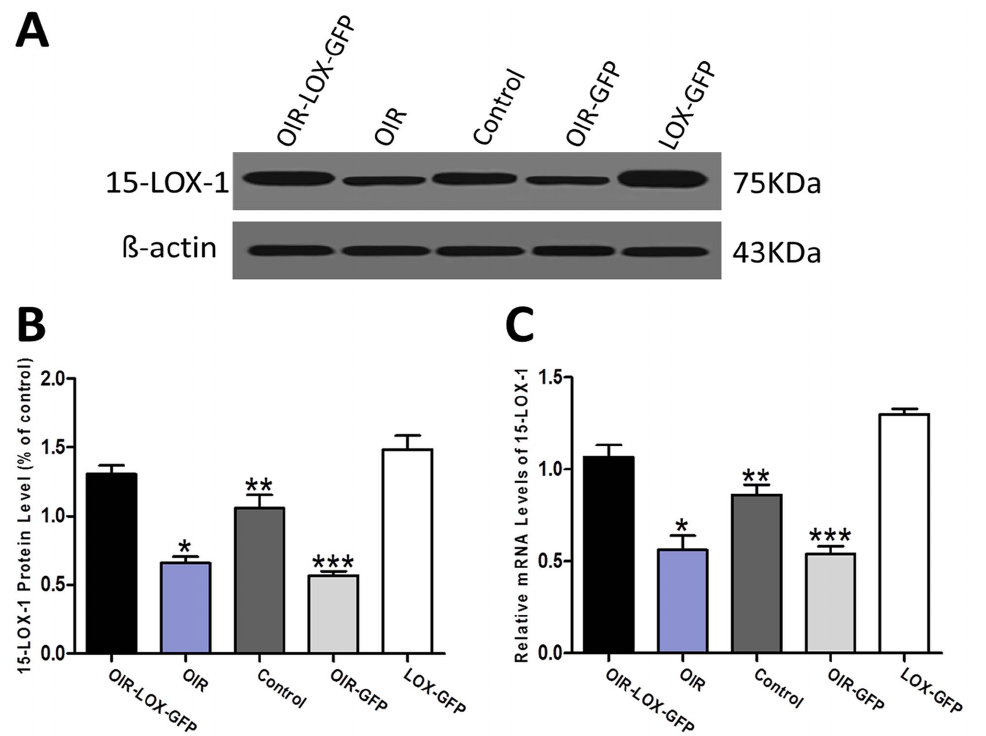
Figure 3. Efficacy of 15-LOX-1 gene transfers into the mouse retina. The efficacy of 15-LOX-1 gene transfers in the retinas of 12-day-old C57BL/6J mice, 5 days after intravitreous injection of approximately 1.0 6 10 9 plaque formation unit of Ad-15-LOX-1-GFP or Ad-GFP. A, B: Western blot analysis confirmed that protein levels of 15-LOX-1 were higher in OIR-LOX-GFP group mouse retinas than those in OIR group, Control group and OIR- GFP group mouse retinas. The bands were quantified by densitometry and normalized by ß-actin, data were analysis as means 6 SD. OIR-LOX-GFP group versus OIR group *p , 0.01; OIR-LOX-GFP group versus Control group **p , 0.01; OIR-LOX-GFP group versus OIR-GFP group ***p , 0.01, n=5. C: Real-time PCR analysis further showed that mRNA levels of 15-LOX-1 in OIR-LOX-GFP group mouse retinas were higher than those in OIR group, Control group and OIR-GFP group mouse retinas. Data were shown as means 6 SD, the relative amount of mRNA was normalized to ß-actin. OIR- LOX-GFP group versus OIR group *p , 0.01; OIR-LOX-GFP group versus Control group **p , 0.01; OIR-LOX-GFP group versus OIR-GFP group ***p , 0.01, n=3.